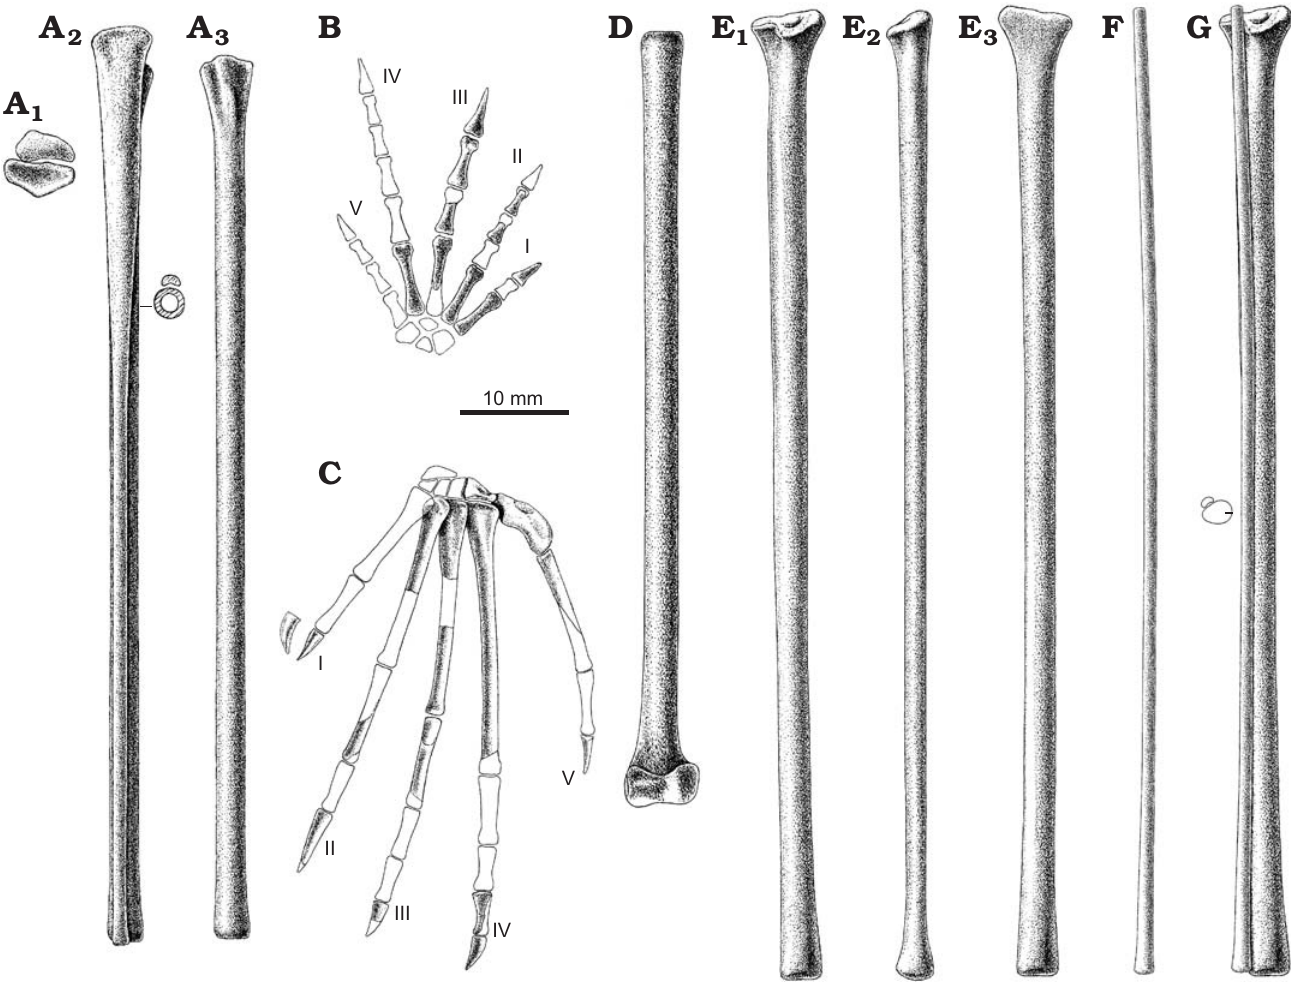
Fig. 12. Restoration of long bones, manus, and pes of long-necked reptile Ozimek volans gen. et sp. nov. A . Right ulna and radius in proximal (A 1 ) and posterior (A 2 ) views, radius in anterior view (A 3 ), based on ZPAL AbIII/2452, /2511. B . Manus, based on ZPAL AbIII/2511. C . Pes, based on UOPB 1148, ZPAL AbIII/3198, /2511. D . Right femur in anterior view, based on UOPB 1148 and ZPAL AbIII/3191. E . Tibia in anterior (E 1 ), lateral (E 2 ), and posterior (E 3 ) views, based on ZPAL AbIII/2526, /2527, /2512. F . Fibula, based on ZPAL AbIII/2512, /2525, /3191. G . Tibia and fibula in anterior view, based on ZPAL